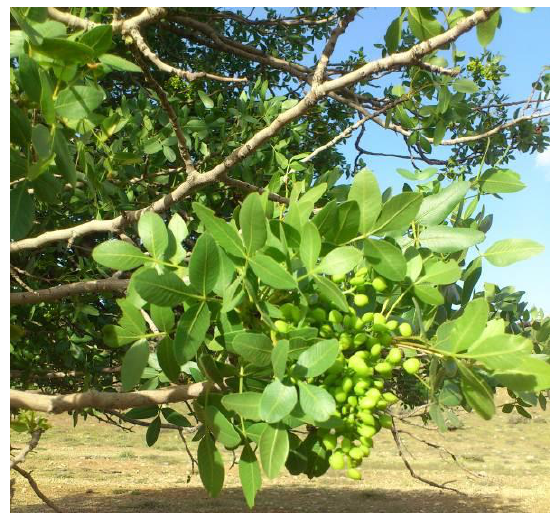
Figure 2. The leaves and fruits of wild pistachio trees in the study area.